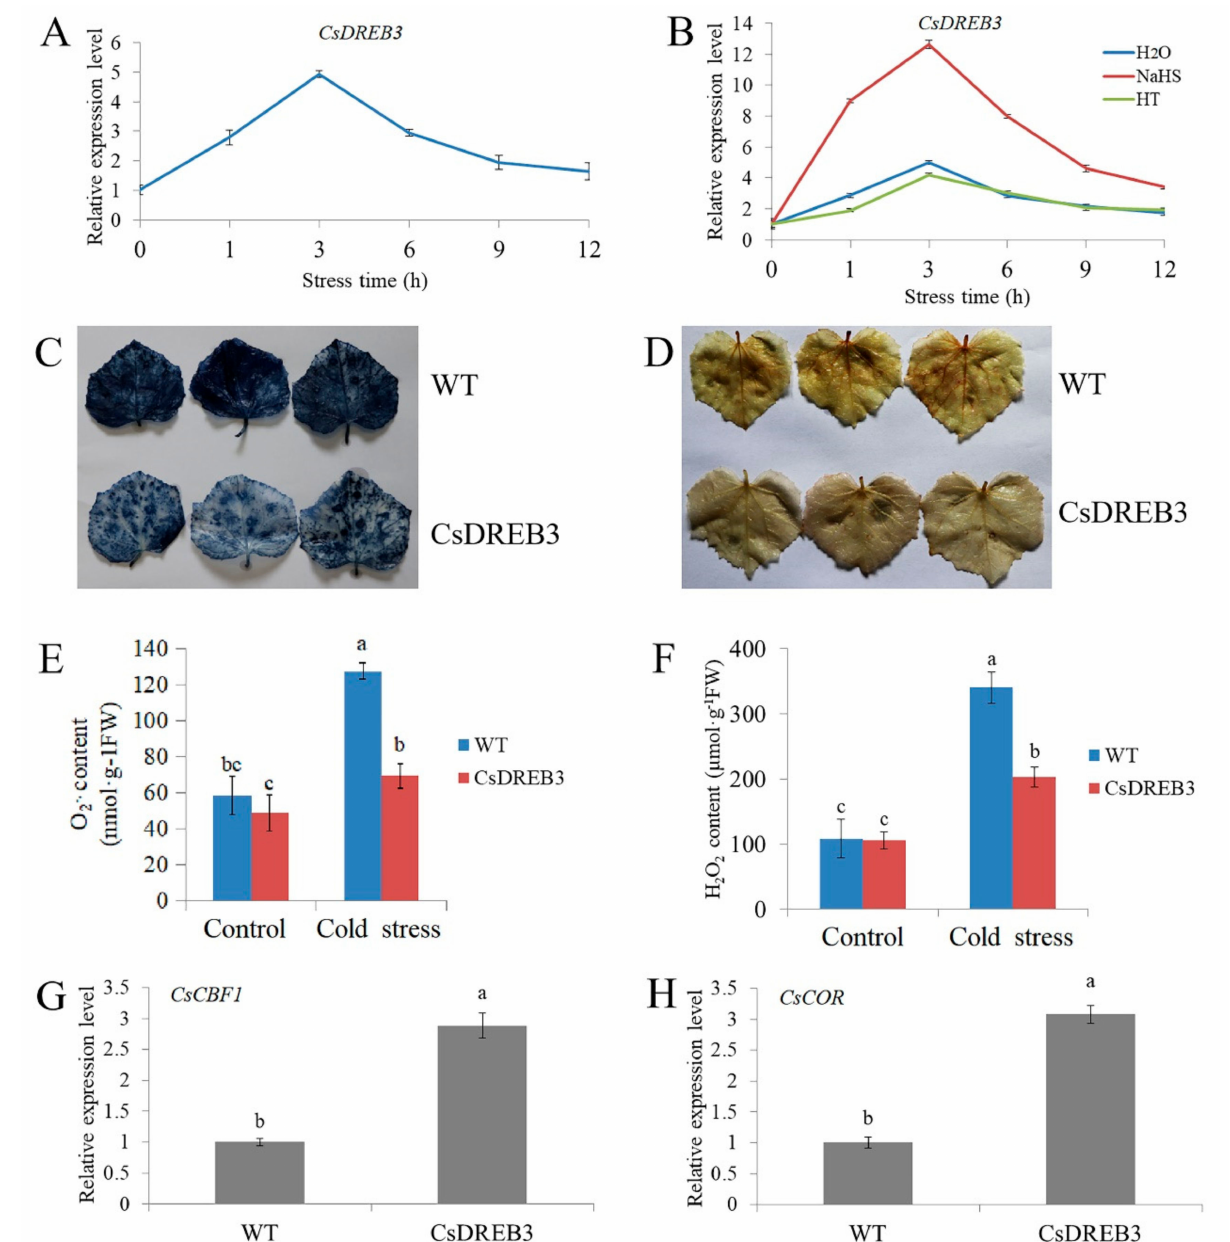
Figure 7. Overexpression of CsDREB3 improves the cold tolerance of cucumber. ( A ) Expression of the CsDREB3 gene in cucumber seedlings under cold stress treatment for 12 h. ( B ) Expression of the CsDREB3 gene in cucumber seedlings treated with NaHS or HT under cold stress treatment for 12 h. ( C , D ) NBT and DAB staining of empty vector control (WT) and CsDREB3 transient transgenic cucumber leaves treated with cold stress for 12 h. Each genotype contained 5–10 cucumber leaves. The experiments were repeated three times with similar results. A typical picture is shown here. ( E , F ) Detection of O 2 ·− and H 2 O 2 contents of transgenic cucumber leaves before (control) and after cold stress treatment for 12 h. ( G , H ) Expression of CsCBF1 and CsCOR genes in transgenic cucumber leaves under cold stress for 3 h. qRT-PCR was performed simultaneously with three biological replicates and three technical replicates. The value of WT was used as the reference and was set to 1. Error bars denote standard deviations. Different letters indicate significant differences ( p < 0.05) based on Duncan’s multiple range